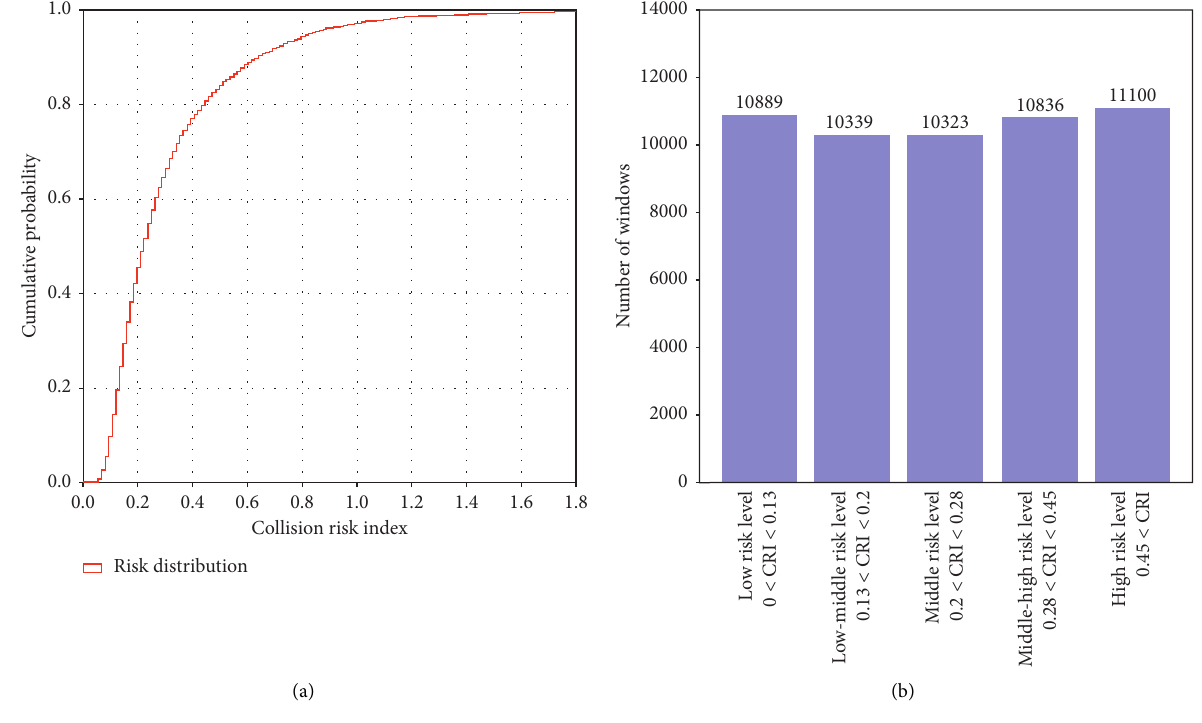
Figure 4: Cumulative probability of CRI and number of CRI in each